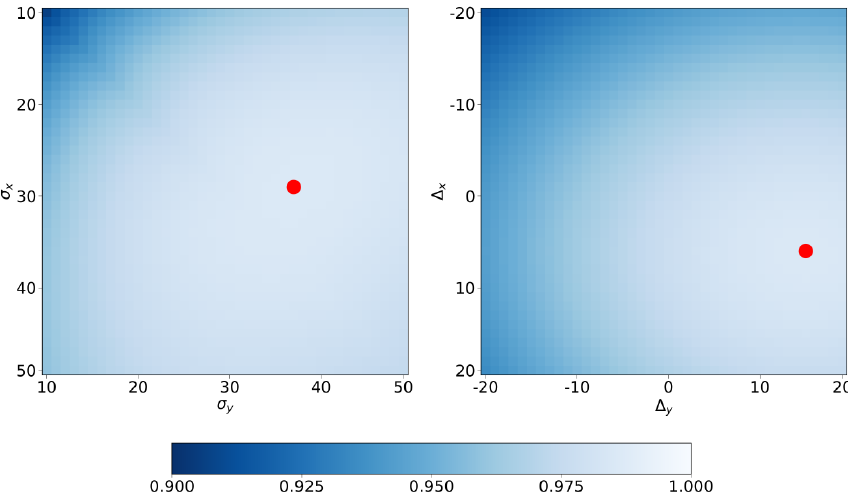
Figure E4. The correlation map between r c ((cid:51)(m)) with ˆ y(G c ) , with different σ x , σ y , (cid:49) x , and (cid:49) y values, in which the red dots represent the largest correlation values’ positions.